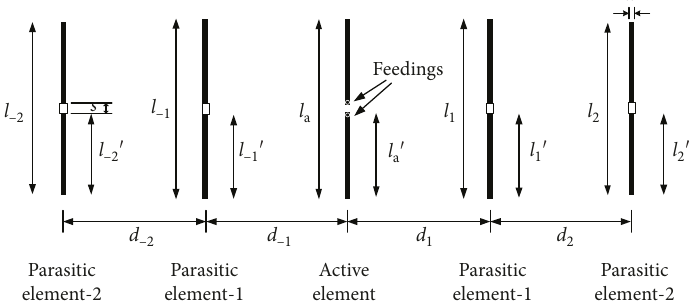
Figure 2: Linear switchable antenna array based on the Yagi-Uda array